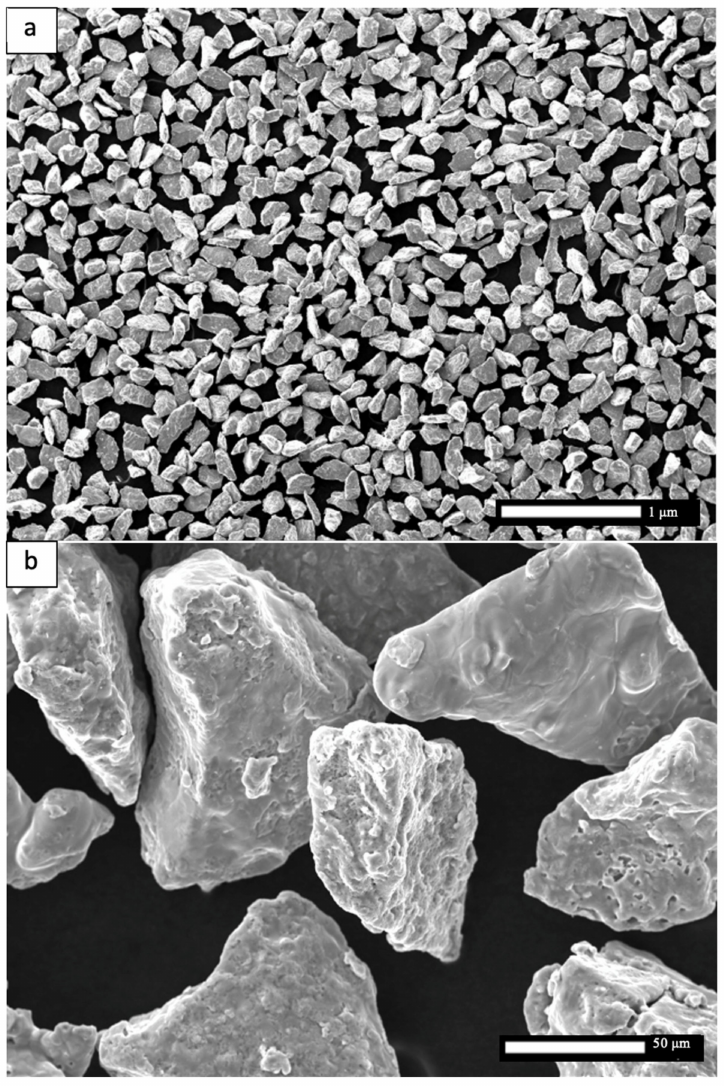
Figure 2. Ti64 HDH powder SEM images. ( a ) Low magnification. ( b ) High